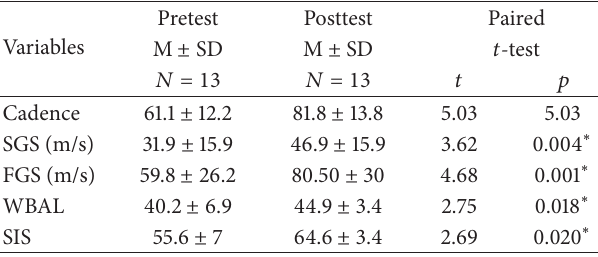
Table 3: Within-group comparison of the dependent variable in FLO group.